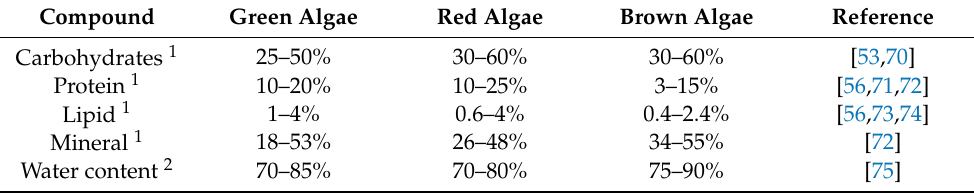
Table 1. Chemical composition of seaweeds (green, red and brown). Compound Green Algae Red Algae Brown Algae Reference Carbohydrates 1 25–50% Protein